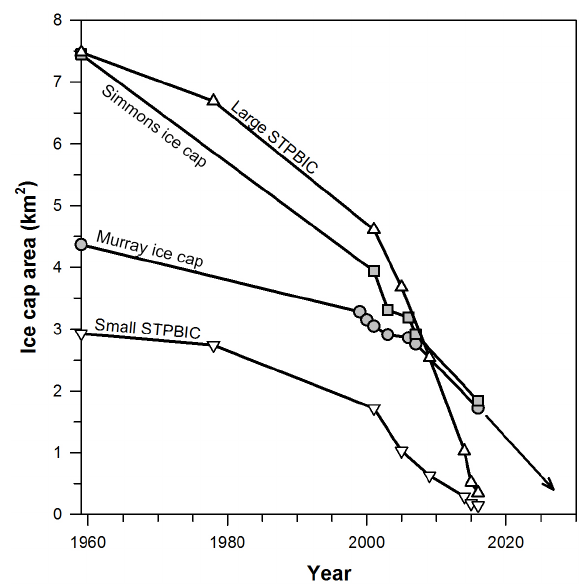
Figure 4. Time history of ice cap areas and projected times of dis-